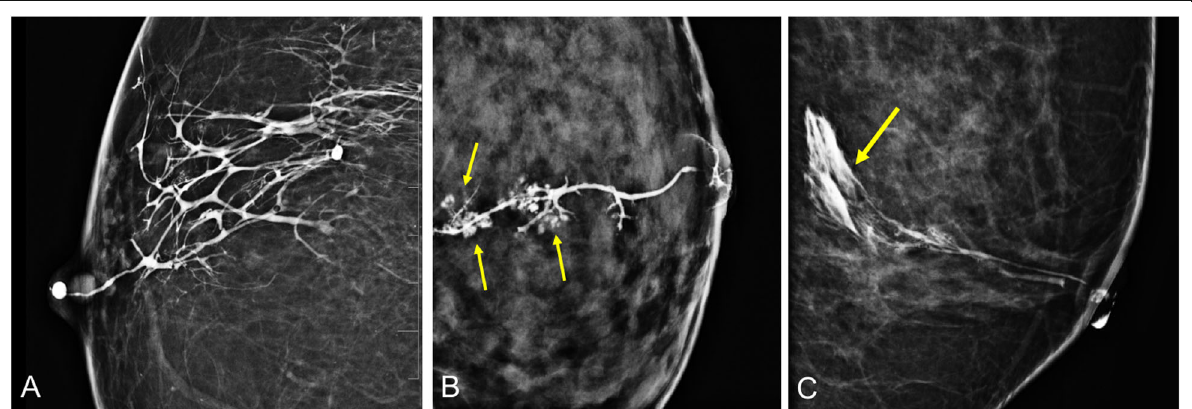
Fig. 15: Ductograms. a Normal ductogram, craniocaudal view. Note the normal “ lobular blush ” in ( b ) (arrows), caused by the contrast material filling the lobular portion of the terminal ductal lobular unit. Ninety-degree mediolateral ductogram ( c ) shows delayed extravasation from excess injection pressure (arrow)